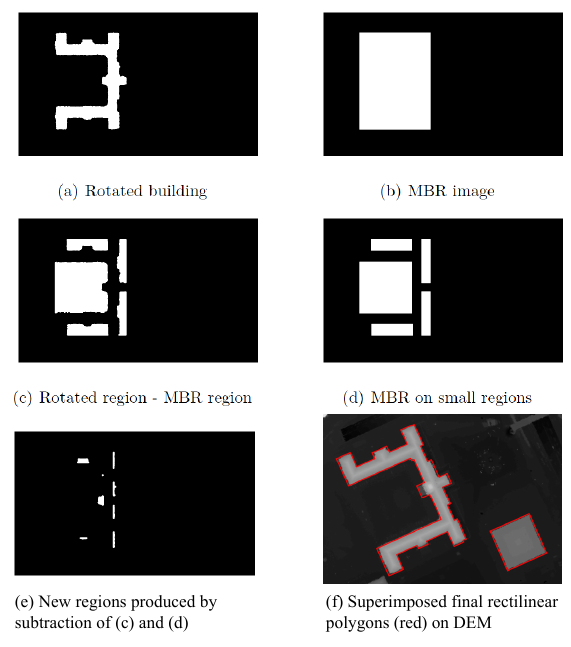
(e) New regions produced by (f) Superimposed final rectilinear subtraction of (c) and (d) polygons (red) on DEM Figure 2: MBR based polygon approximation in Figure 2. Accordingly, after determination of the main orientation, the building polygon is rotated to the main ori- entation, as shown in Figure 2(a). In the next step the MBR image (cf. Figure 2(b)) is subtracted from the rotated build- ing region. After subtraction, new regions will be produced (cf. Figure 2(c)). For any of those regions a MBR will be calculated (Figure 2(d)). They are again subtracted from their corresponding regions produced in the previous step (cf. Figure 2(e)). As illustrated in Figure 2(e) some small regions are created. The process is followed by comput- ing new MBR regions and subtracts them from their cor- responding regions. This hierarchical procedure is contin- ued until ”no regions” are produced any more. That means the progress stops when either no new regions created any more or the size of produced regions is less than predefined threshold. After convergence the final polygon is rotated back to original orientation ( cf. Figure 2(f)). In this figure the red lines highlight the rectangular